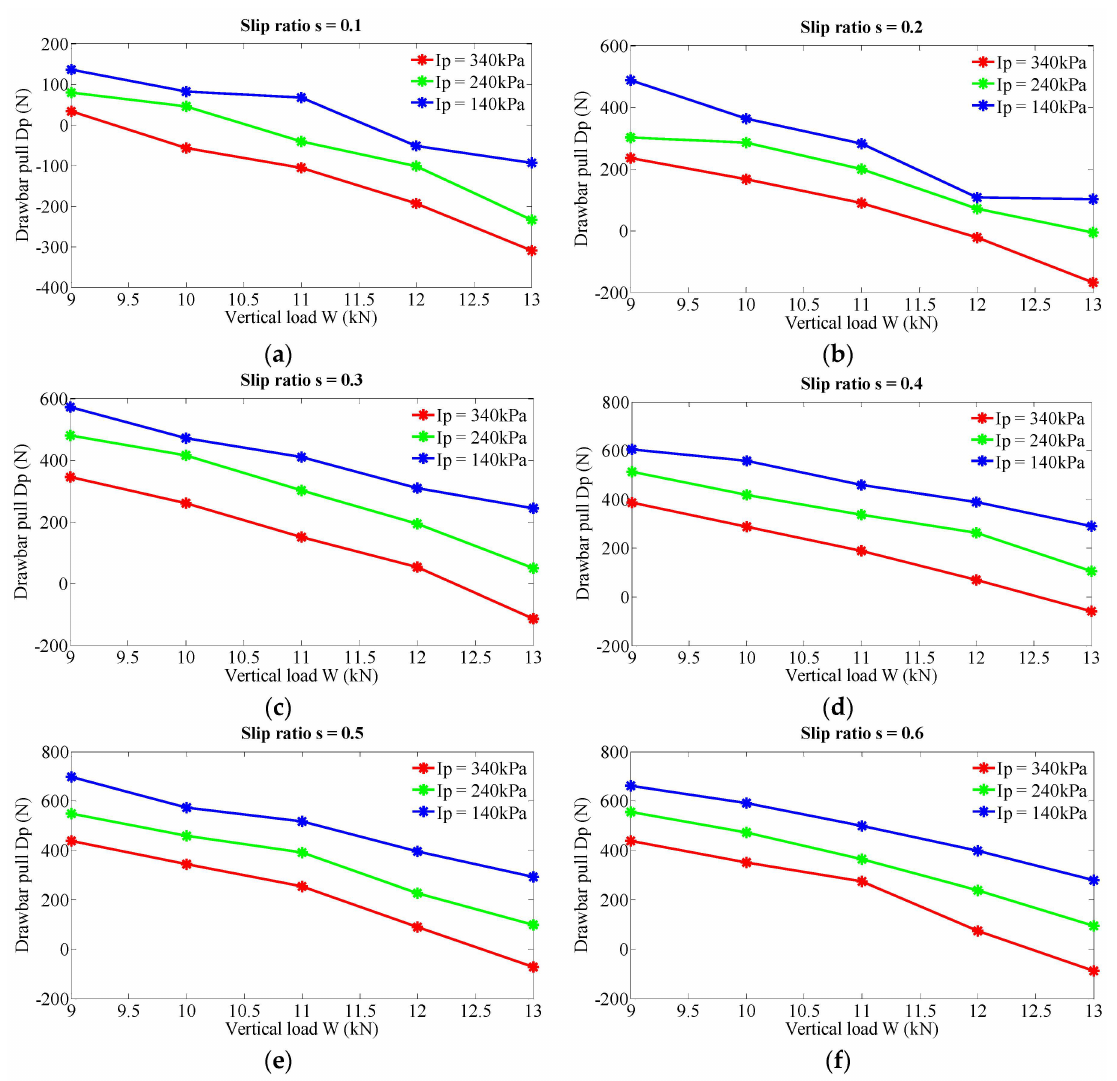
Figure 3. Effect of vertical load on drawbar pull at various levels of inflation pressure and slip ratio. ( a ) Slip ratio s = 0.1; ( b ) Slip ratio s = 0.2; ( c ) Slip ratio s = 0.3; ( d ) Slip ratio s = 0.4; ( e ) Slip ratio s = 0.5; ( f ) Slip ratio s = 0.6.